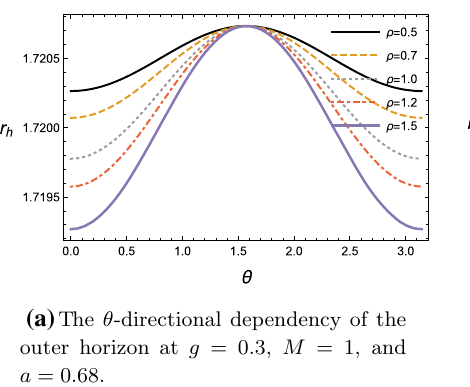
(c) The θ -directional dependency of the The surface of the outer horizon under ρ = 1, g = 0 . 3, M = 1, and a = 0 .